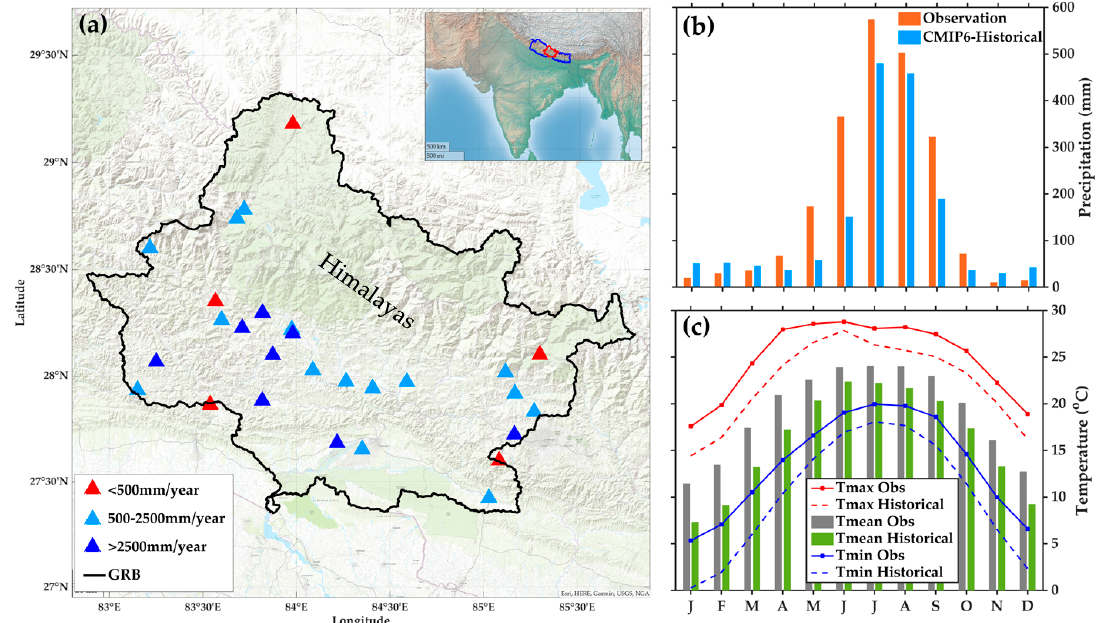
Figure 1. ( a ) Study area and spatial distribution of mean precipitation over GRB obtained from 28 meteorological stations. The monthly cycle of ( b ) average precipitation and ( c ) temperature over GRB during 1985–2014.